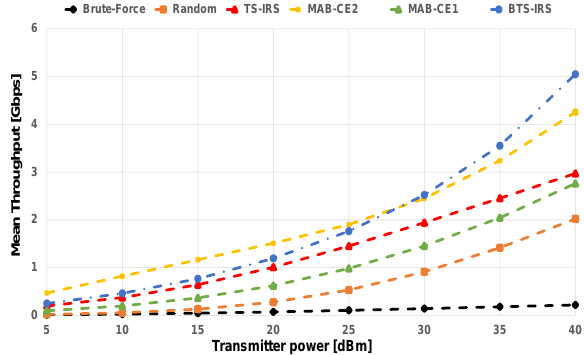
Figure 4. Mean throughput versus transmitter power